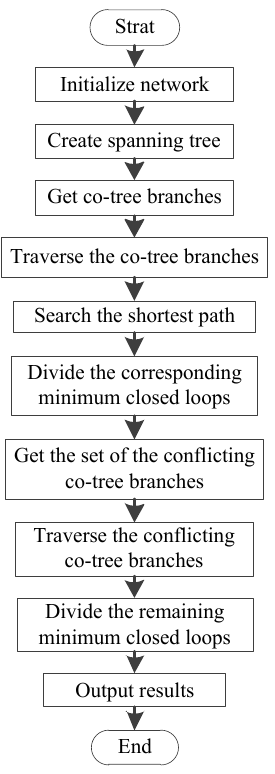
Figure 5. Flow chart of the improved minimum independent closed (MICL) algorithm.